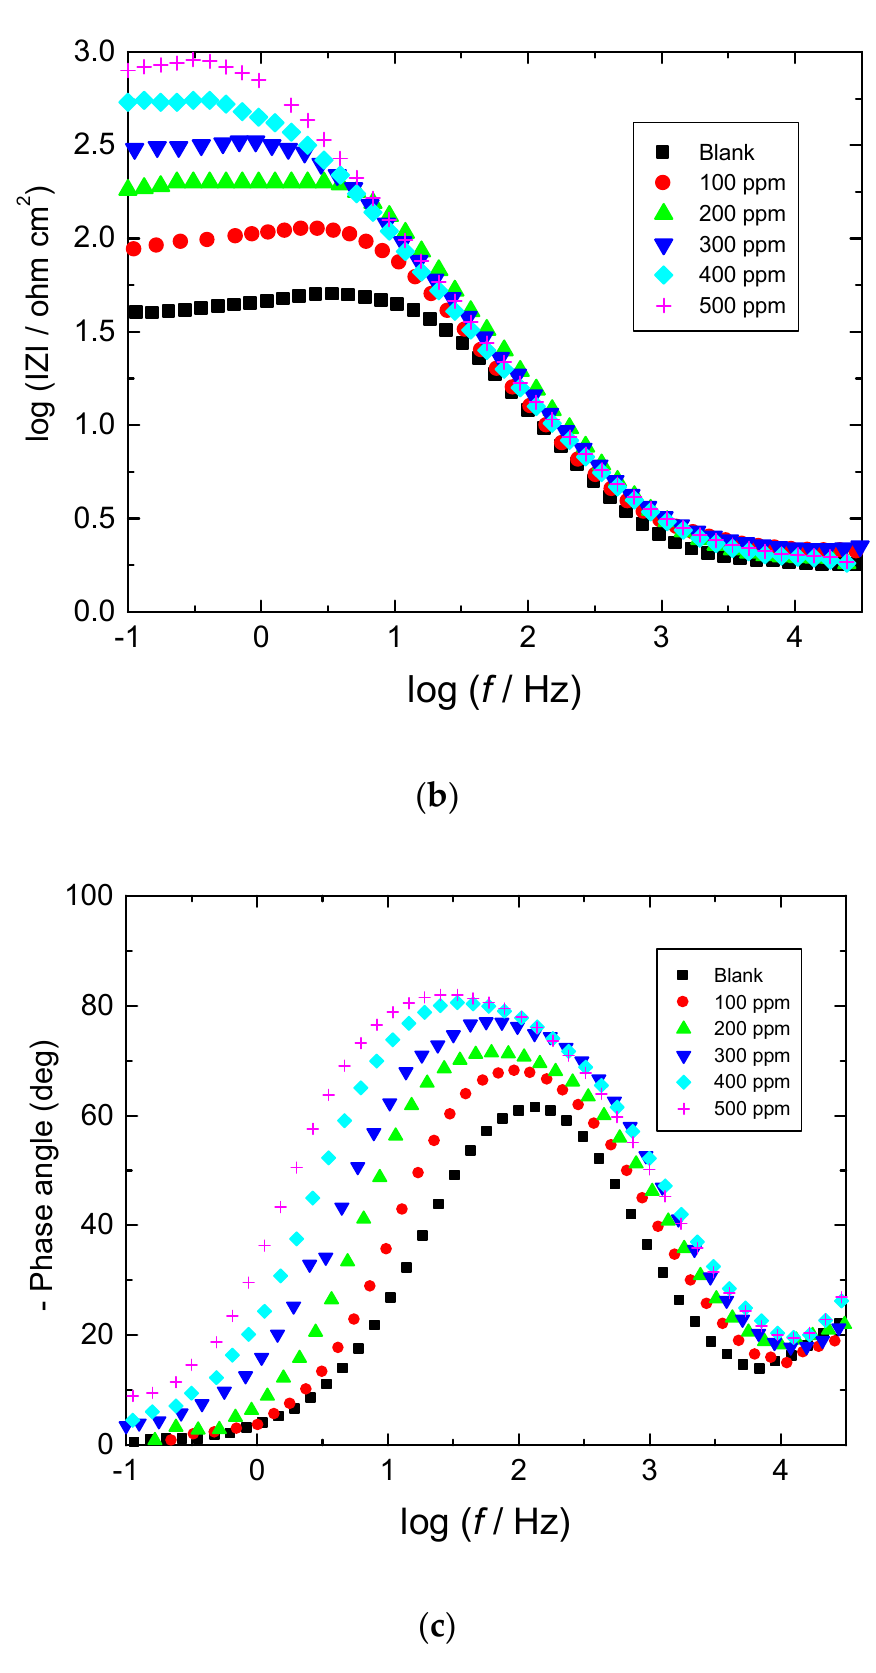
Figure 4. Plots of: (a) Nyquist, (b) Bode magnitude, and (c) Bode phase for mild steel in 0.5 M HCl solution at 303 K in absence and presence of chitin.